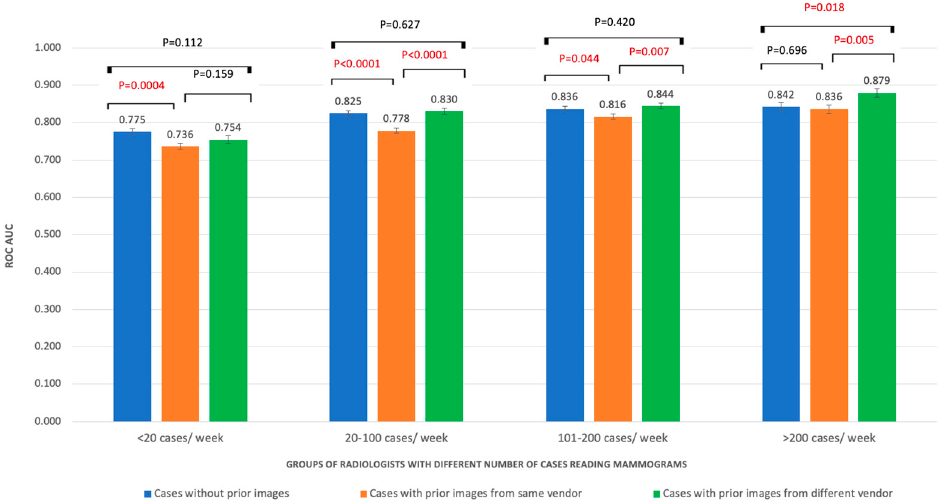
Figure 2. ROC AUC performances of radiologists with different experience in number of cases read per week.